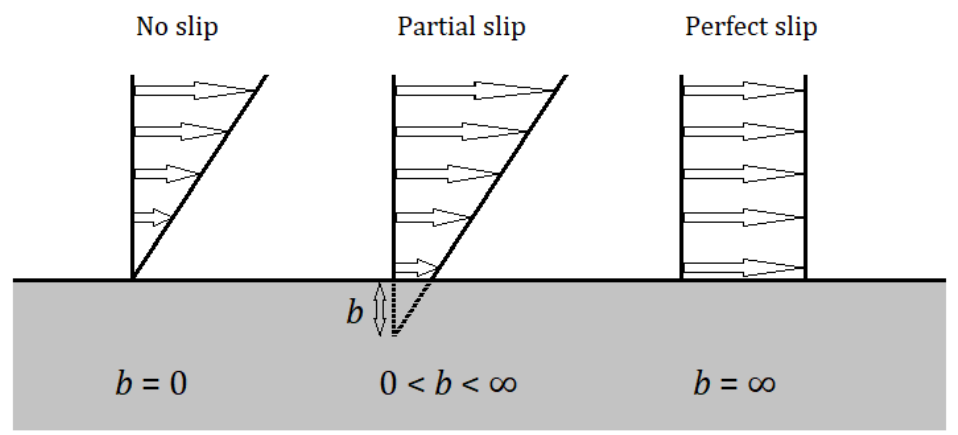
Figure 8. Slip regimes.